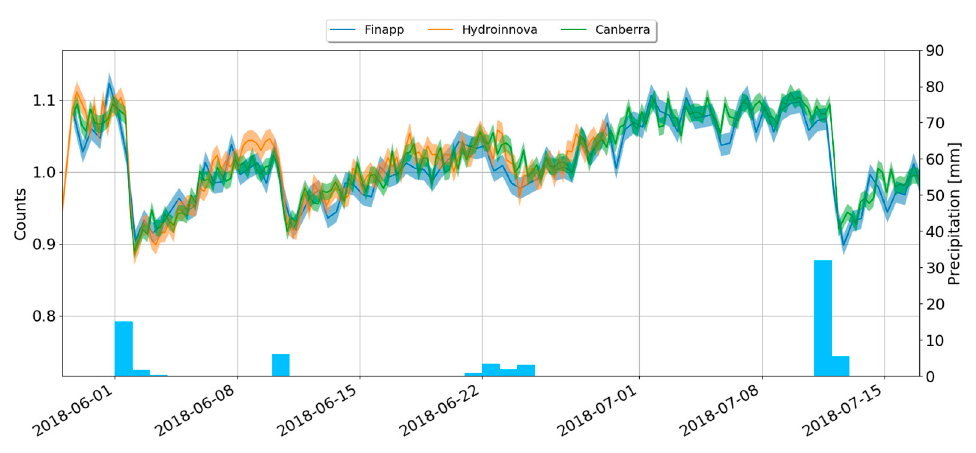
Figure 7. Epithermal counts: Finapp (blue), CRS-1000 from Hydroinnova (orange), and He-3 tube from CANBERRA (green). Data is corrected for atmospheric pressure variations. The colored zone indicates statistic uncertainty. Daily rain is reported in the bottom part of the plot.